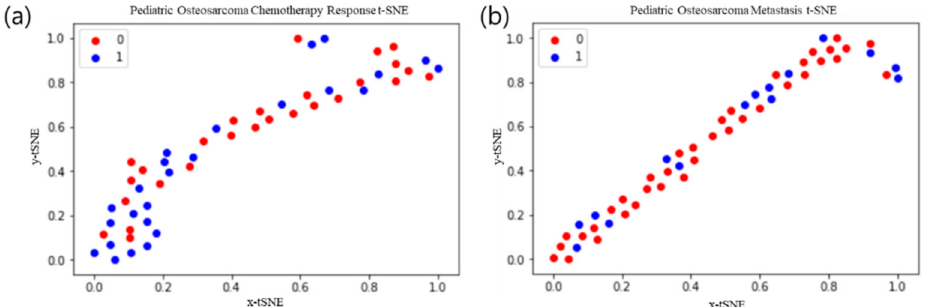
Figure 3. t-Distributed stochastic neighbor embedding (t-SNE) of texture features from 47 images. The 0/1 values represent non-responders and respondents, respectively. ( a ) Chemotherapy response t-SNE; ( b ) metastasis